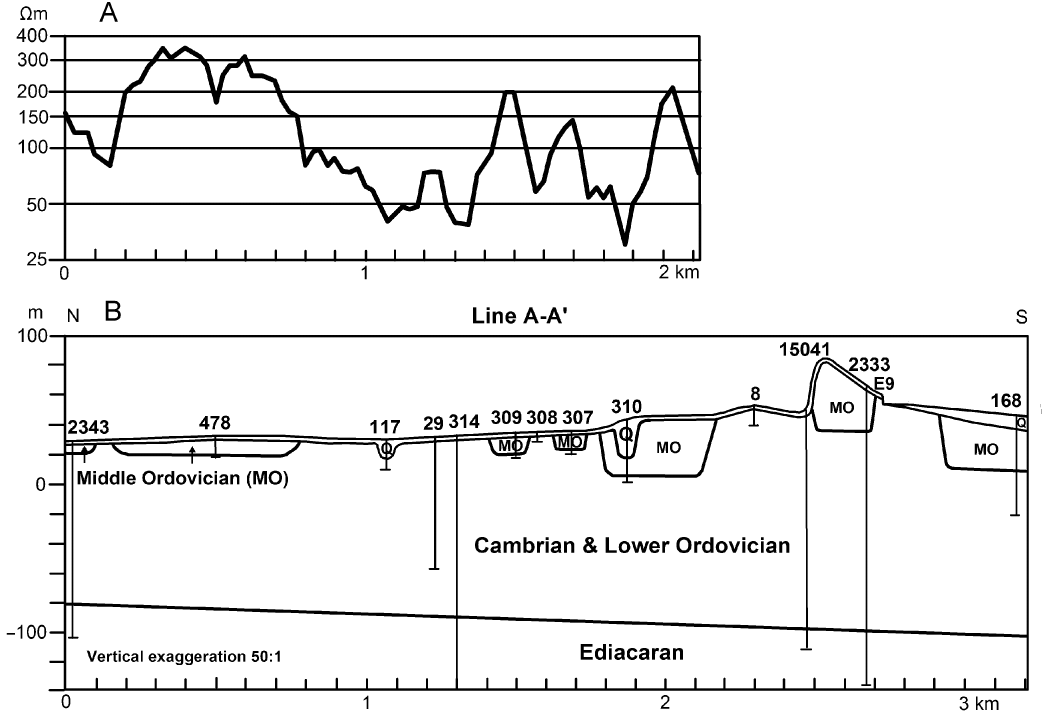
Fig. 3. Diapirs, northeastern Estonia: resistivity curve ( A ) and cross section ( B ) (modified after Vaher & Mardla 1969). For location of the cross section along line A(cid:150)A ′ see Fig. 2. Notation: Q, Quaternary; MO, Middle Ordovician; E,